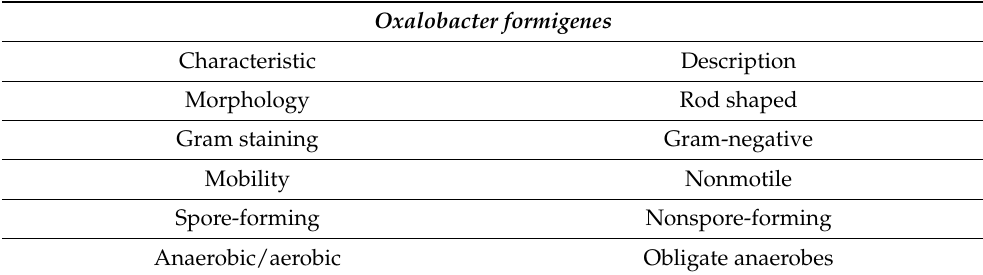
Table 2. Characteristics of Oxalobacter formigenes .